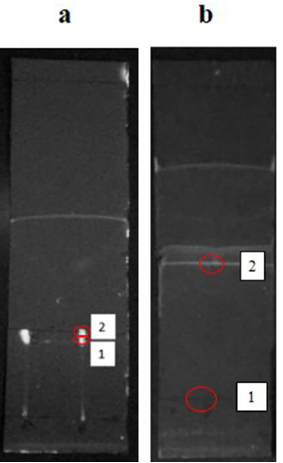
Figure 2. Thin layer chromatography (TLC) results of G. sulphureus defense fluid extract in plate a and standard band in plate b under 254 nm UV light in a UV Viewing Chamber (UVITEC, England, United Kingdom). The red circle indicates a band obtained on both plates.